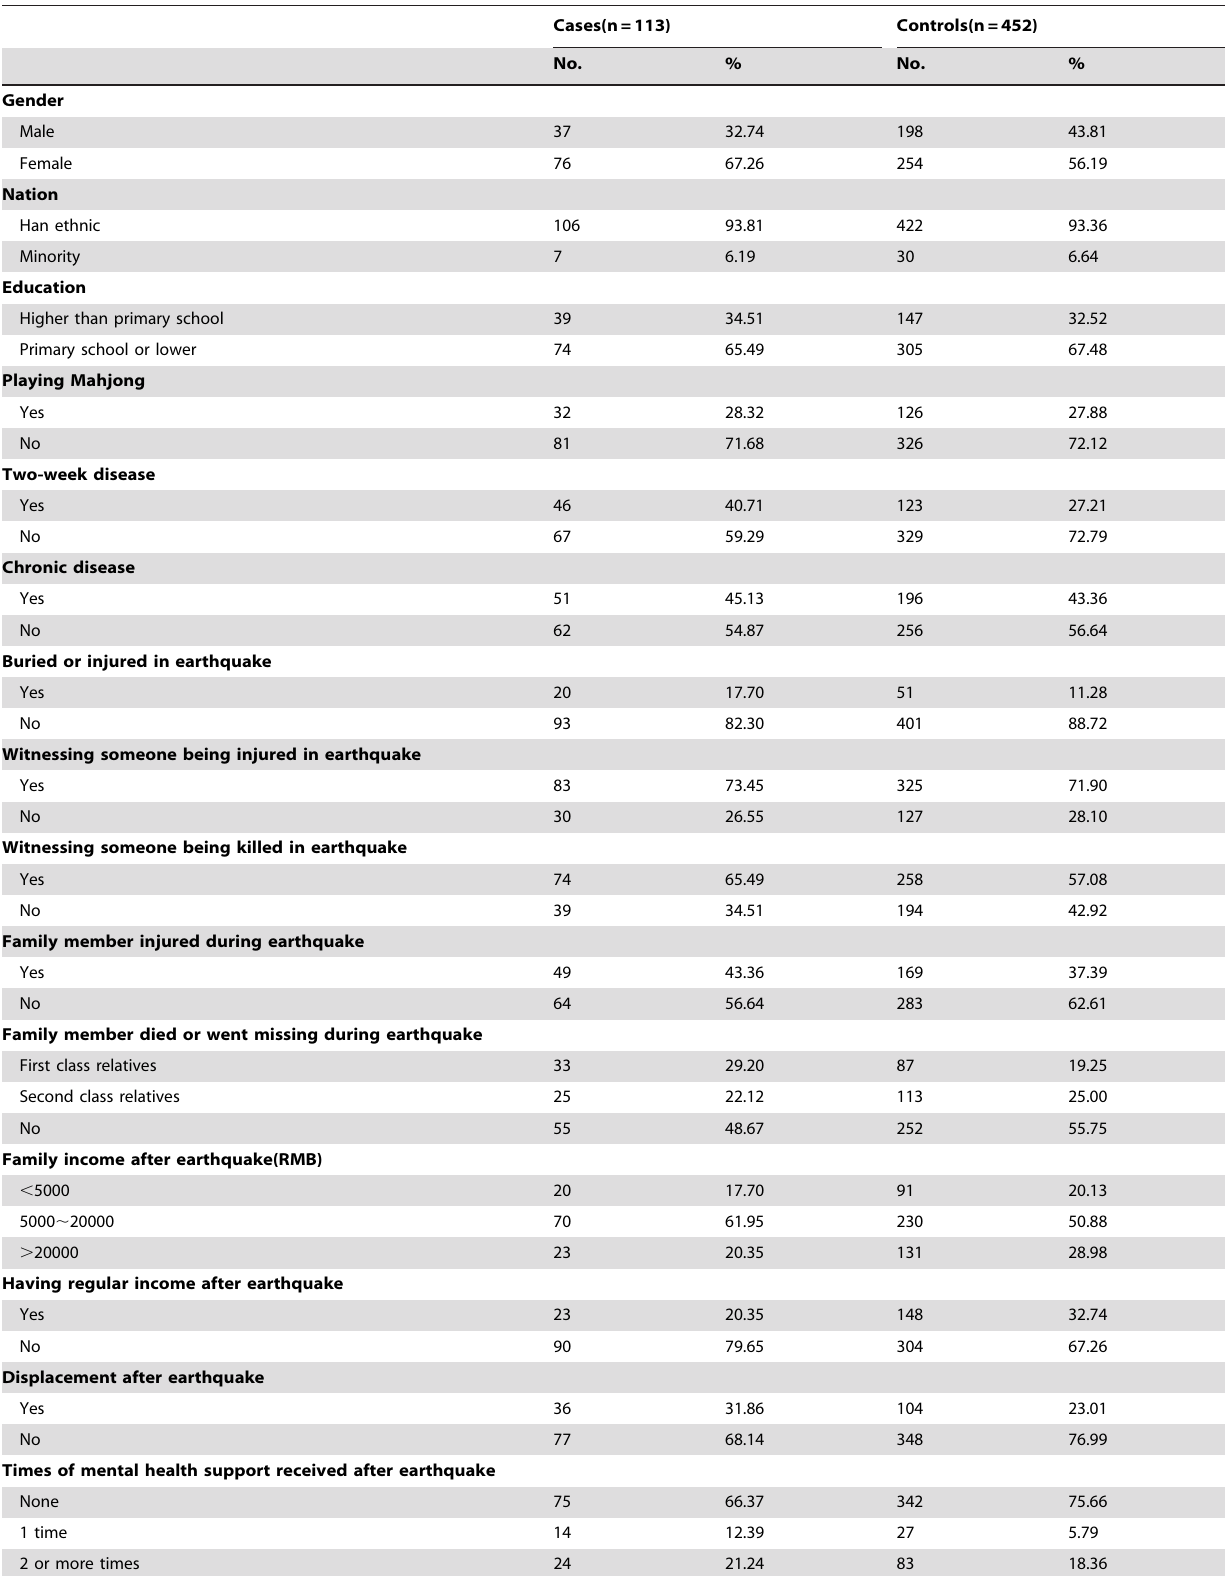
Table 1. Factors related to cases and